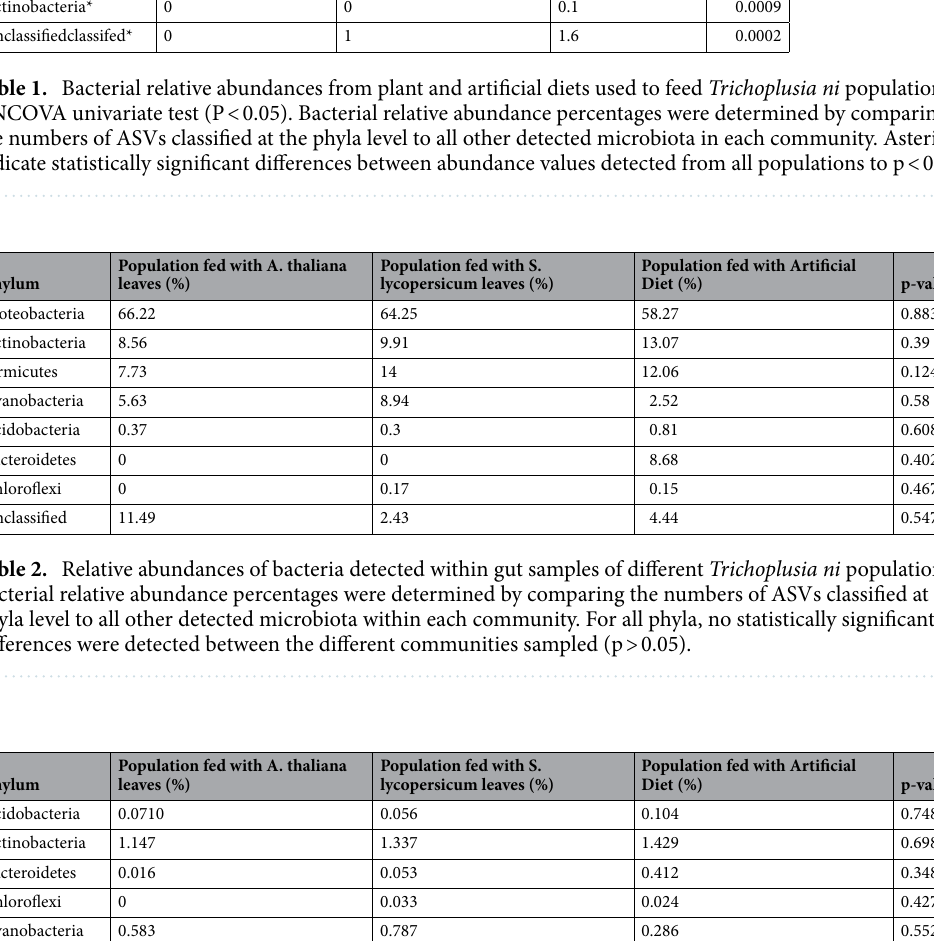
Our PICRUSt analysis was used to locate genes within the glycosidases category of the KEGG Enzymes database in the microbial community in order to predict the presence of enzymes that degrade glu- cosinolates or glycoalkaloids naturally produced within the administered diets ( A. thaliana or S. lycopersicum ) (Table 4, Supplementary Table S4) 24,26 . For the predicted functions of bacterial genes present in insects fed with S. lycopersicum leaves, the rela- tive abundance values of glycosidase-enzymes were observed to be significantly higher when compared with A. thaliana -fed communities (Table 4). The predicted functional genes significantly increased in relative abundances when insects were fed with the S. lycopersicum diet were as follows: alpha-amylase (EC.3.2.1.1),